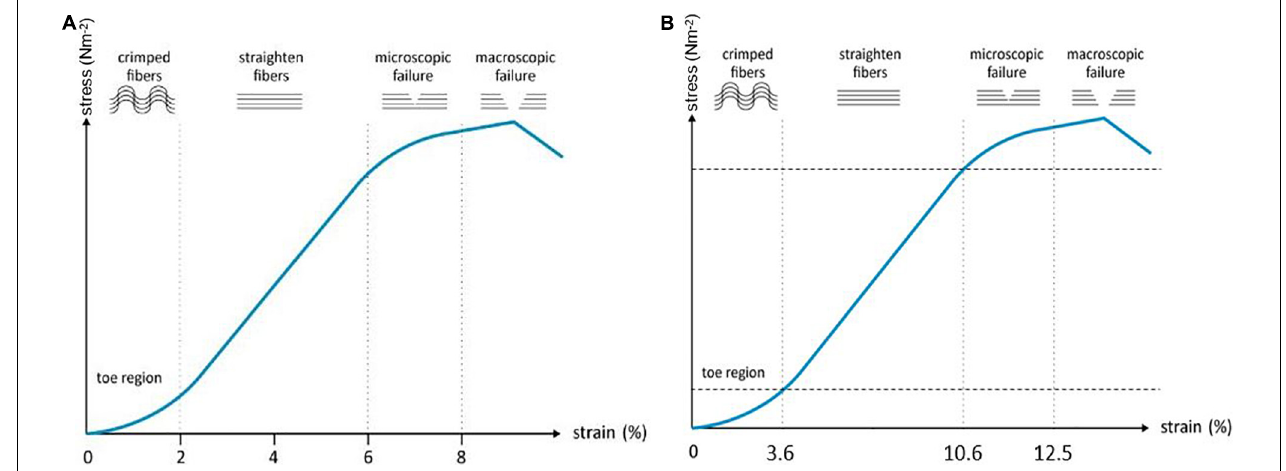
FIGURE 9 | (A) Stress-strain curve of the human Achilles tendon. (B) Stress-strain curve of the equine superficial digital flexor tendon. Stress: applied force over area, Strain: deformation in response to stretch, Elasticity: stress/strain ratio or how force results in a deformation of the tissue. Adjusted from Barfod